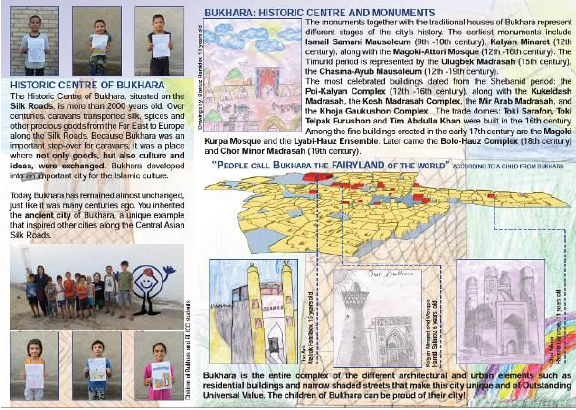
Figure 18. Children’s leaflet of the Historic Centre of Bukhara ©UNESCO